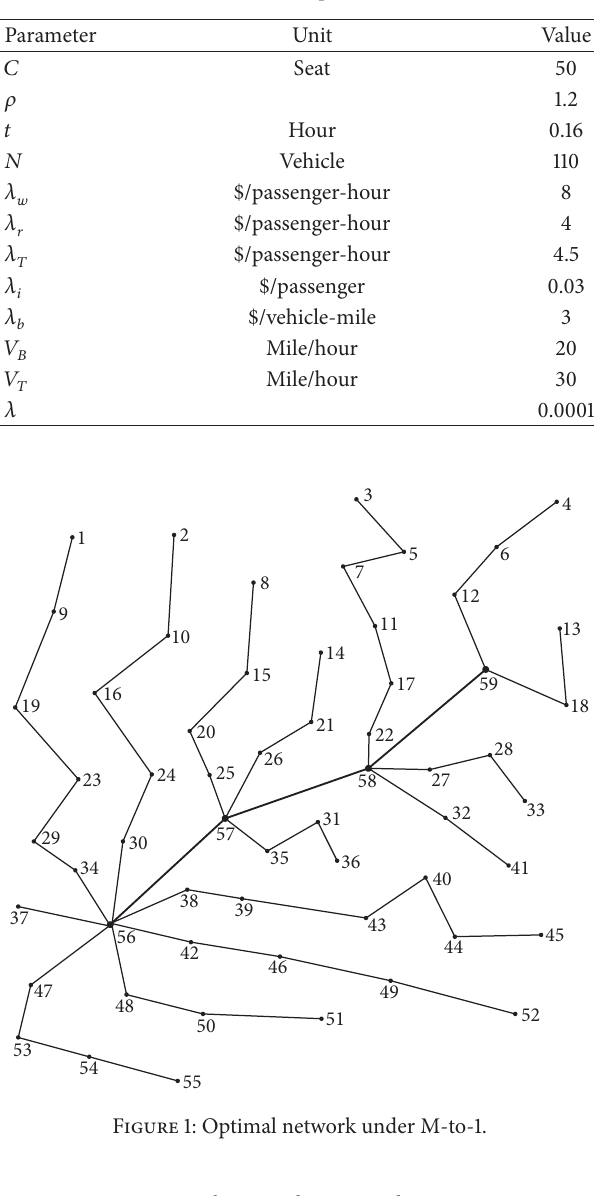
Table 1: Model parameters.